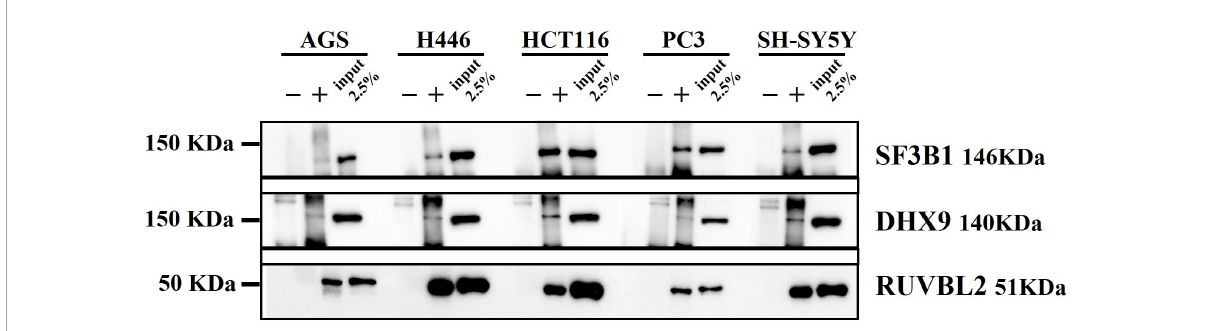
FIGURE6 Western blot from DnaK immunoprecipitation comparing the five cancer cell lines. On the left side the Molecular Weight (MW) Marker is indicated. On the right side the name and MW of each validated protein are given. For each of the five cell types, three samples were loaded: the immunoprecipitated DnaK-transfected lysate with the antibody isotype control, the immunoprecipitated DnaK-transfected lysate with anti-V5 antibody and 2.5% load of the Dank-transfected lysate used for the